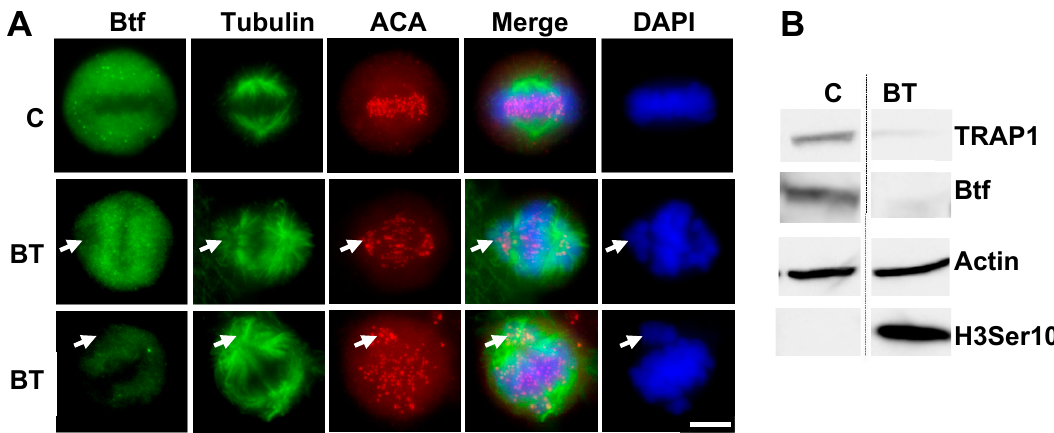
Figure 1. Depletion of Btf and TRAP150 causes chromosome misalignment defects. ( A ) HeLa cells were transfected with siRNA duplexes targeting Btf and TRAP150 mRNA (BT) or control siRNA duplex (C) and processed for immunolocalization of Btf, beta-tubulin and ACA 72 h post-transfection; DNA was stained with DAPI. Merge is shown for beta-tubulin and DAPI. Arrows indicate misaligned chromosomes. Scale bar, 5 µ m; ( B ) Immunoblot of HeLa cell extracts 72 h following treatment with control siRNA (siGENOME2) or siRNA duplexes targeting Btf and TRAP150 (BtfSi1 and TRAPSi4) confirmed Btf and TRAP150 protein depletion with actin as a loading control. Anti-H3Ser10P detected phosphorylated histone H3Ser10. Scale bar = 5 μ m.